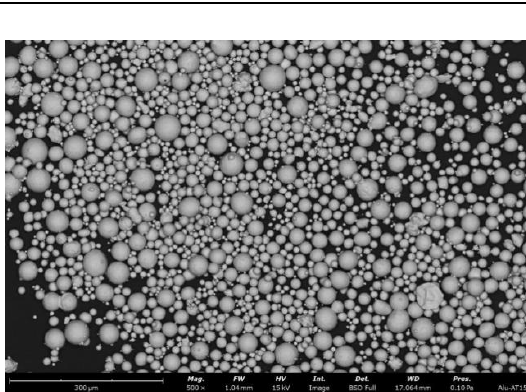
Figure 5. Morphology characteristics of Ti6Al4V powders. Table 3. SLM process parameters.